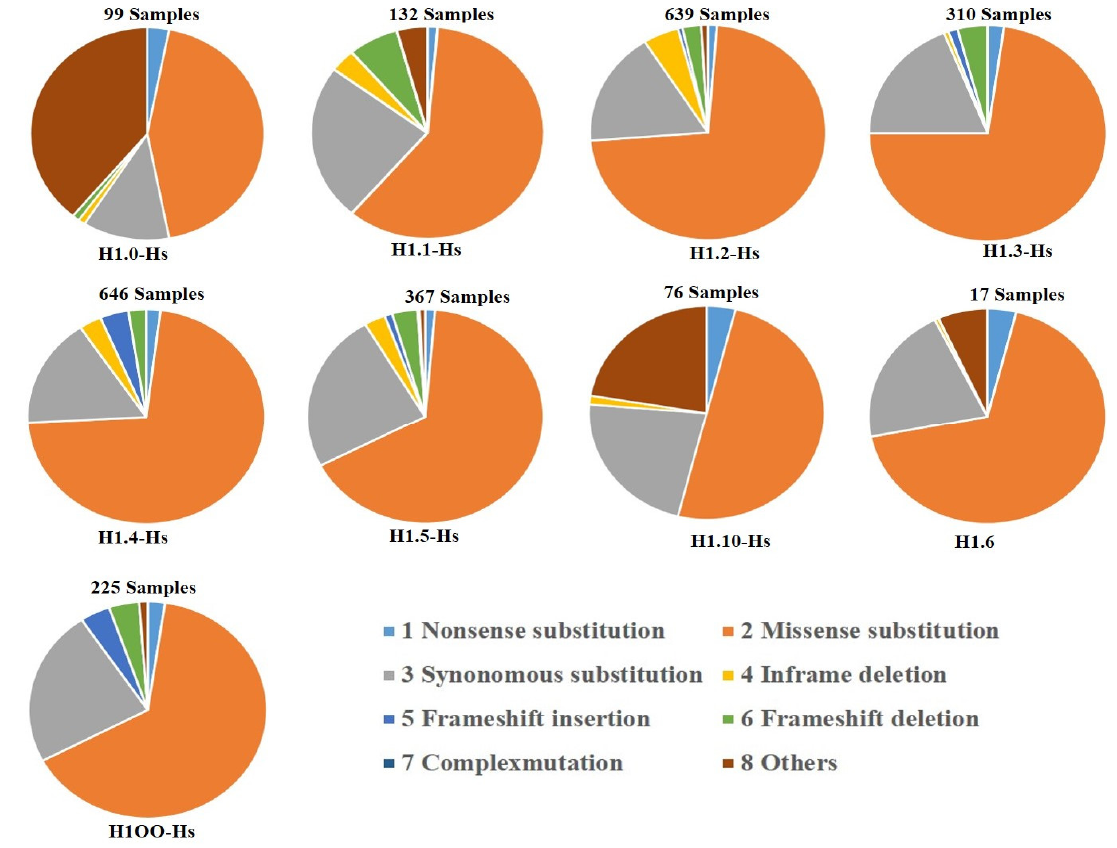
Figure 3. Mutations in Human Linker histone: The pie chart derived from information available at COSMIC database (https://cancer.sanger.ac.uk/cosmic) on 30 October 2022 indicates various mutations observed in different cancerous tissue of the patient samples. The frequency of distribution of mutations are indicated in percentage.